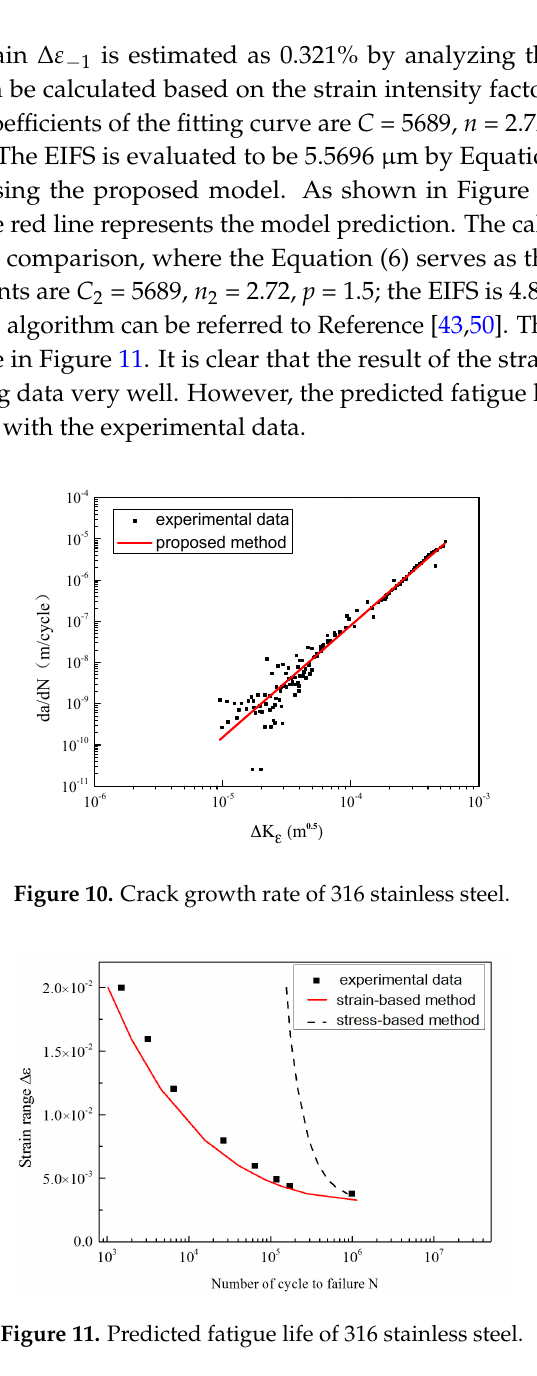
Table 4. Chemical composition of extruded AZ31 magnesium alloy (wt %).